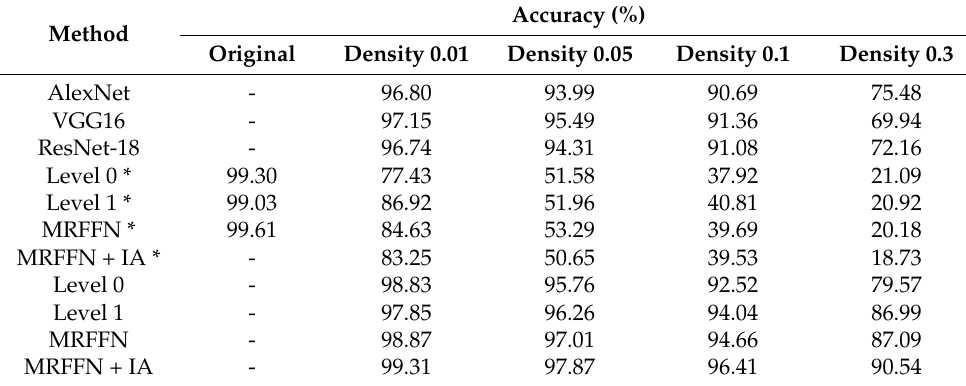
Table 5. The performance of the proposed method on salt and pepper noise.